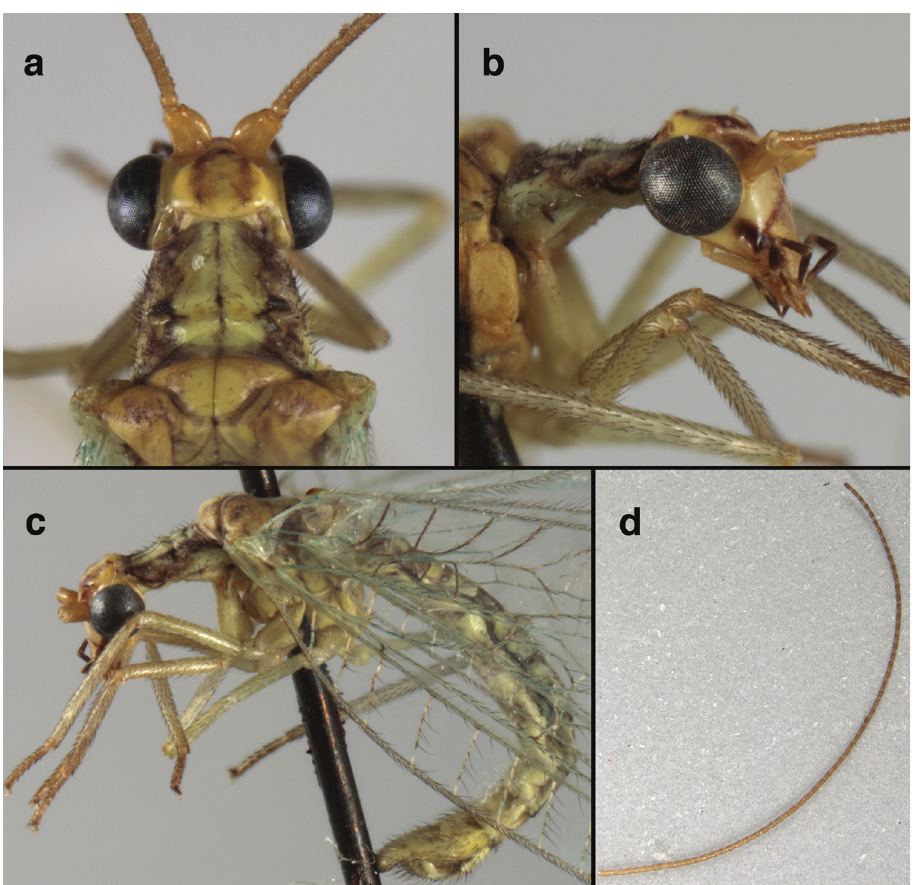
Figure 116. Ungla chacranella (Banks): External features, ( a ) head, prothorax, mesothorax (part), dorsal ( b ) head, prothorax, lateral ( c ) body, lateral ( d ) antenna (all: Argentina, La Rioja, male, FSCA). maxillary palp with basal two segments pale, distal segments brown; labial palp with basal segment pale, distal two segments brown. Prothorax green mesally, with wide, brown, lateral stripes, thin, brown mesal stripe; transverse furrow in posterior region, not reaching lateral margins; short, dark setae throughout. Mesothorax, metathorax yellowish brown with light brown mark- ings. Measurements: head width, 1.2–1.4 mm; ratio head width : eye width, 2.4–2.6 : 1; prothoracic length, 0.5–0.8 mm; prothoracic width, 0.8–1.0 mm. Forewing, hindwing clear, hyaline, without fumose areas, with slender venation; stigma lightly opaque, with three to six light to dark brown subcostal crossveins below stigma surrounded by dark brown marks; all veins, except anal veins, cream-colored to light green, without suffusion. Forewing 9.8–13.4 mm long, 3.3–4.8 mm wide (ratio, L : W = 2.8–3.1 : 1); height of tallest costal cell 0.6–1.0 mm (cell number 6–8); width of first intramedian cell 0.7–0.9 mm; 10–12 radial cells (closed cells